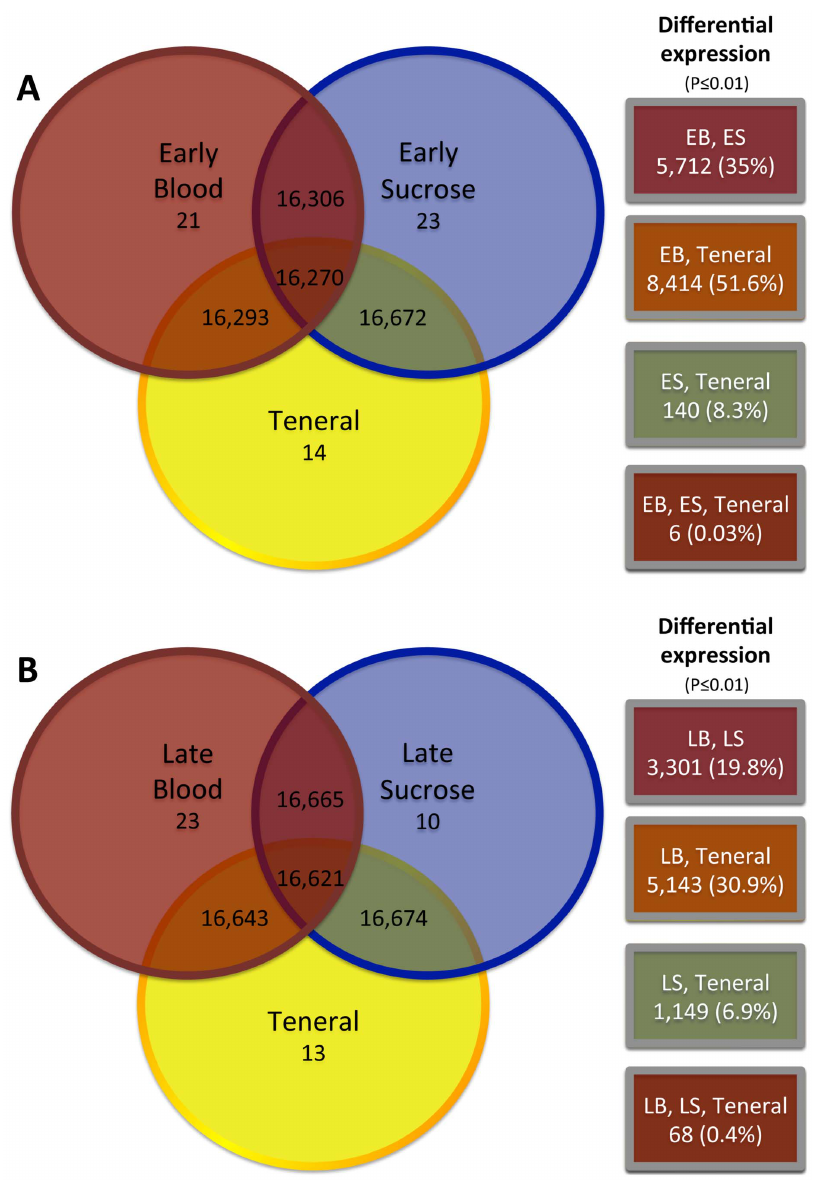
Figure 6. Transcriptome profiles and temporal expression analysis (early or late) across diet (sucrose or blood) in female Culicoides sonorensis . Comparison of the genes that were unique and shared between: A. teneral and early blood (EB) and sucrose (ES) meals (both 2, 6, 12 h post ingestion, pooled), or B. teneral and late blood (LB) and sucrose (LS) meals (both 36 h). Right (boxes): The number of genes with differential expression profiles (P # 0.01), and the percent of shared unigene (in parentheses).